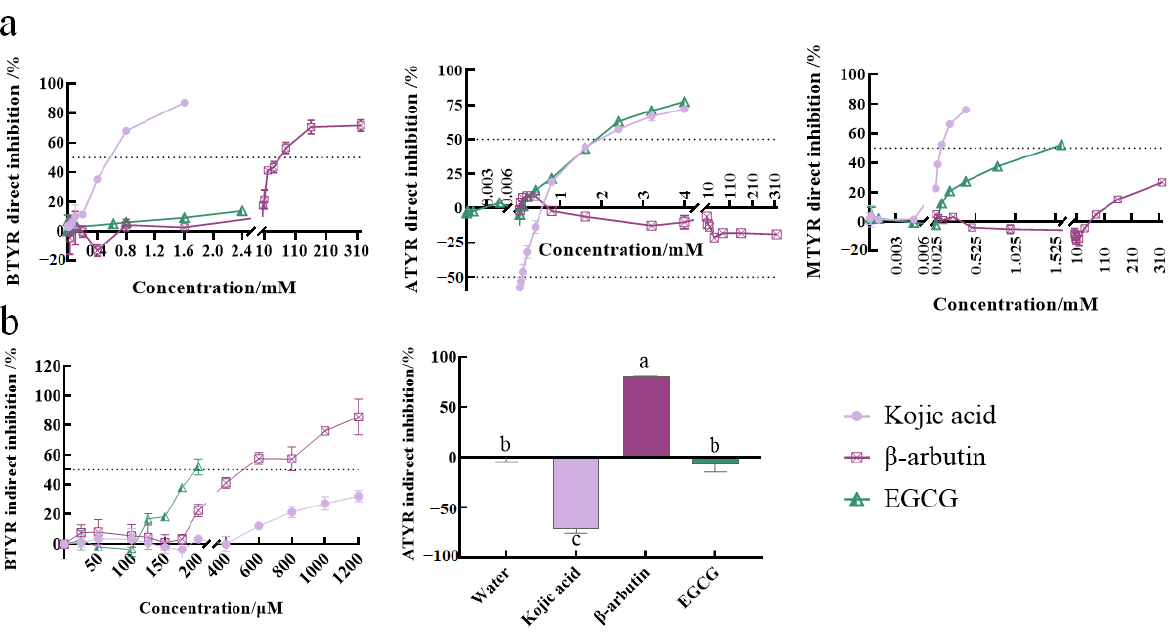
Figure 1. Tyrosinase (TYR) inhibitory activities of compounds were influenced by sample addition methods and enzyme species. ( a ) TYR directly inhibitory activity of compounds. After extracting enzyme solution, the enzyme, sample and substrate were mixed for enzymatic reaction in the non- cellular system. At this time, the influence of sample on enzyme activity was called TYR directly inhibitory activity. The enzymes extracted from B16F10 cells, apple and mushroom were referred to as BTYR, ATYR and MTYR, respectively. Whether the effects of compounds on TYR activity being affected by enzyme species was compared in the three subgraphs of ( a ); ( b ) TYR indirectly inhibitory activity of compounds. After sample treatment for a period of time, crude enzyme solution was extracted from B16F10 cells or apple, and then mixed with substrate for enzymatic reaction. At this time, the influence of sample on enzyme activity was called TYR indirectly inhibitory activity. a,b,c Different letters above the column indicated significant differences ( p < 0.05).